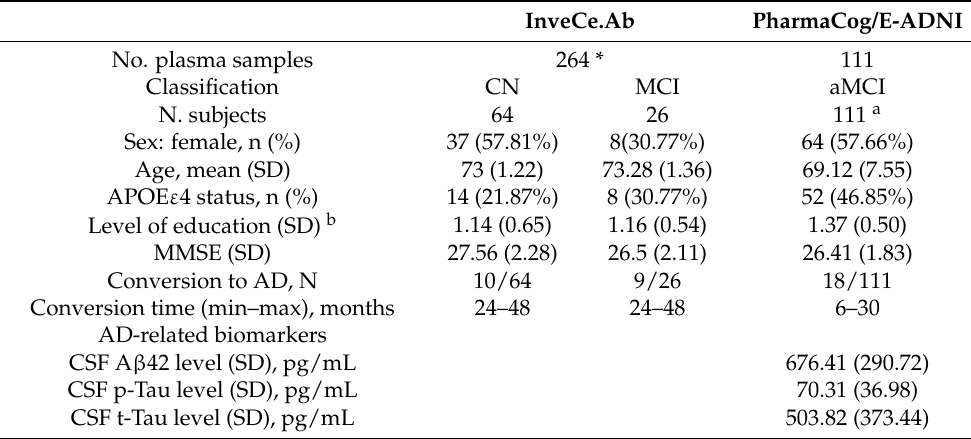
Table 1. Demographic and clinical profile of the subjects. Demographic and clinical variables and genotype frequency of the APOE ε 4 polymorphisms of all the subjects. N: number; M: male; F: female; MMSE: Mini-Mental State Examination; CN: cognitively normal subjects; MCI: mild cognitive impairment; aMCI: amnestic mild cognitive impairment; AD: Alzheimer’s disease; CSF: cerebrospinal fluid. Data are expressed as mean ± standard deviation (SD). For female prevalence and genotype, absolute frequencies (%) are reported.